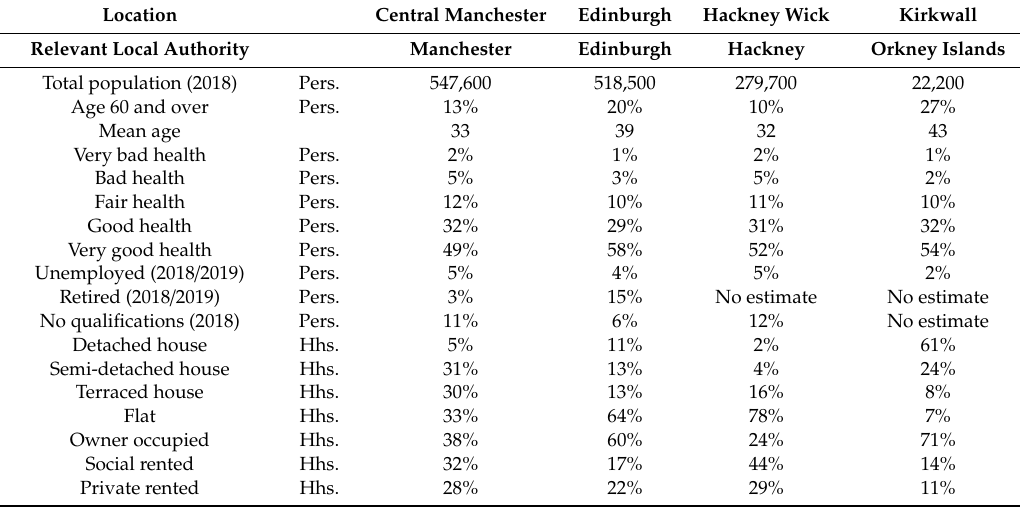
Table 1. Demographic data for the four study